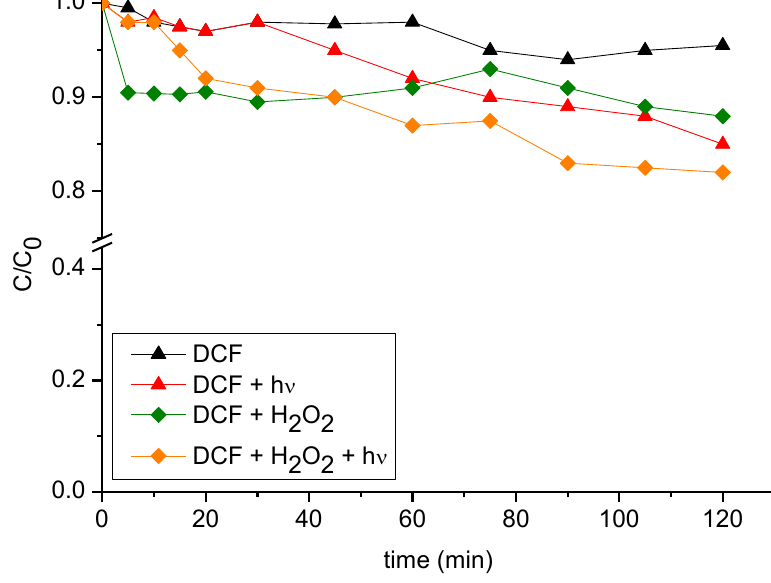
Figure 4. DCF concentration (C 0 = 20 mg L − 1 ) profiles without any additional substances (black triangles), under irradiation (red triangles), in presence of stoichiometric H 2 O 2 (green diamonds), in presence of stoichiometric H 2 O 2 and under irradiation (orange diamonds). Data reported consider a final time of 120 min.